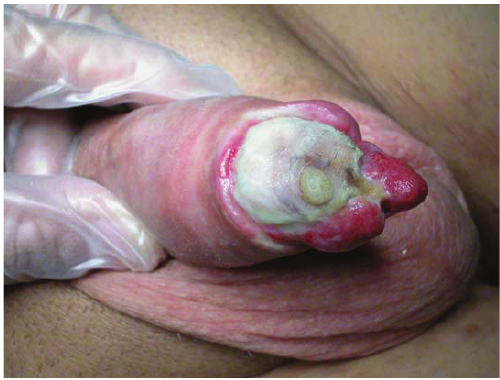
Figure 2: Distal erosion with massive glans necrosis.